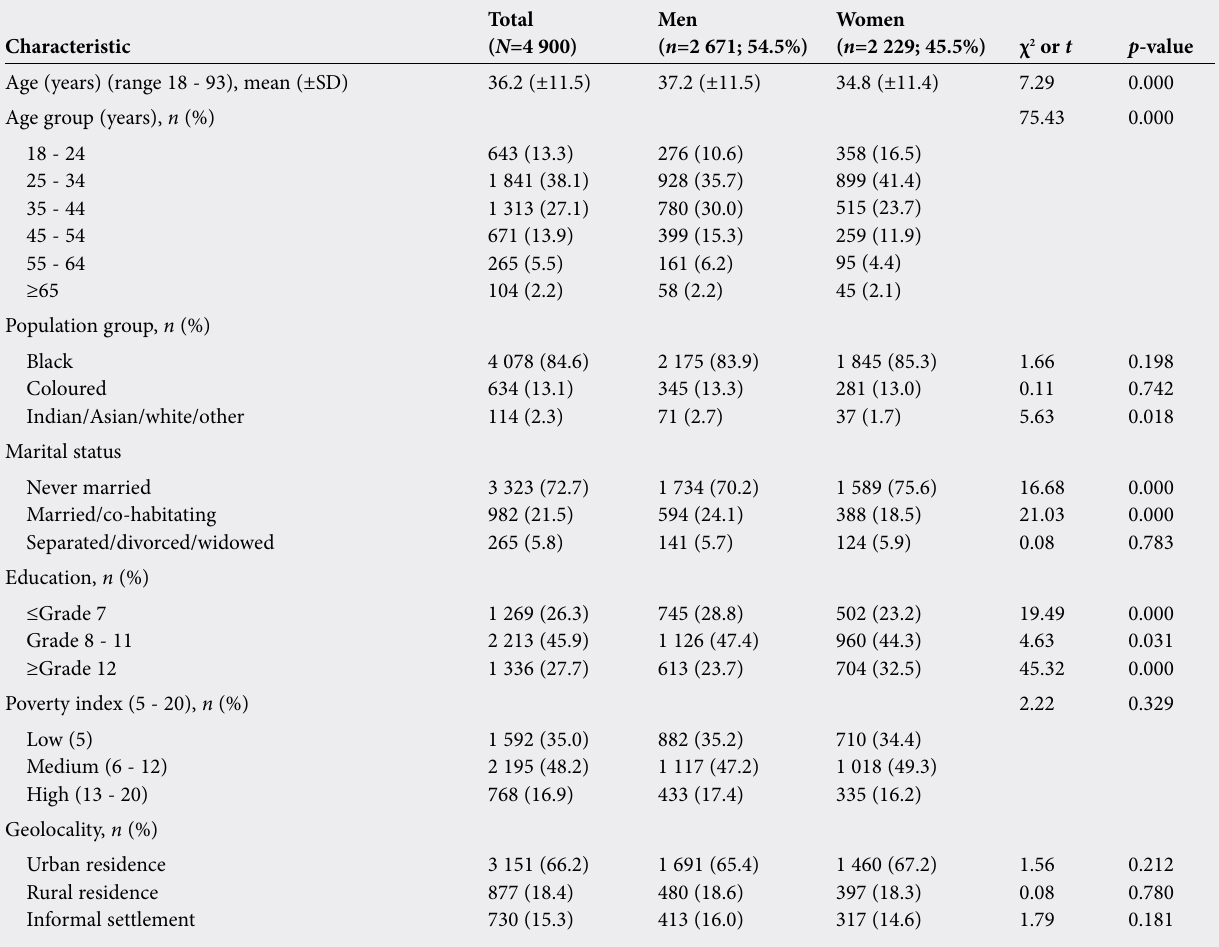
Table 1. Socioeconomic characteristics of the sample